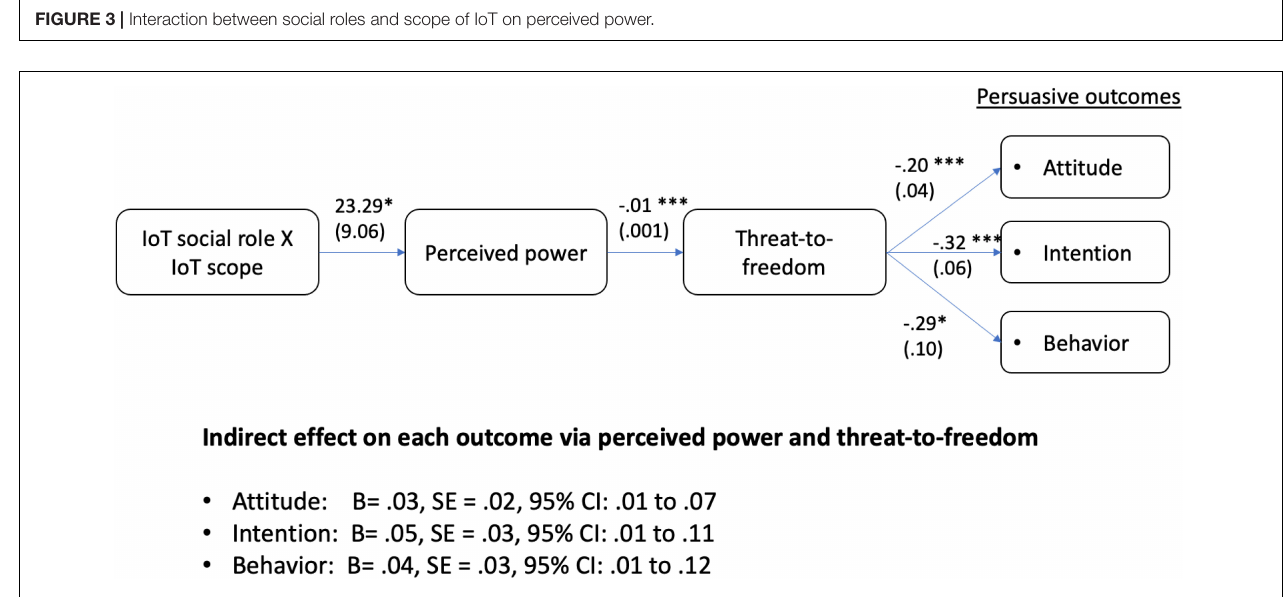
FIGURE 4 | Interaction between IoT social role and scope on persuasive outcomes via perceived power and threat-to-freedom. Unstandardized coefficient B (Standard Error); * p < 0.05, *** p < 0.001; gender, age, and main effects of IoT social role and scope were entered as covariates.